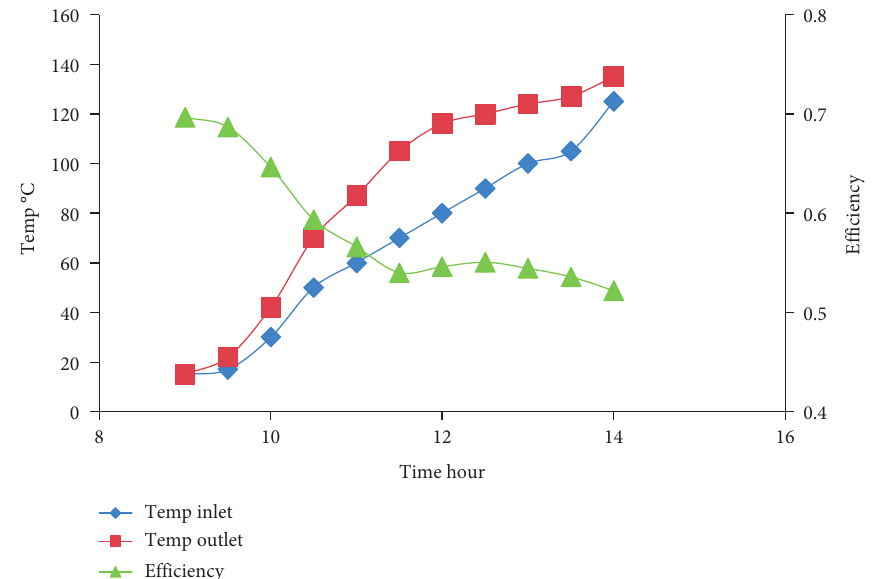
Figure 8: Relation between efficiency with time and